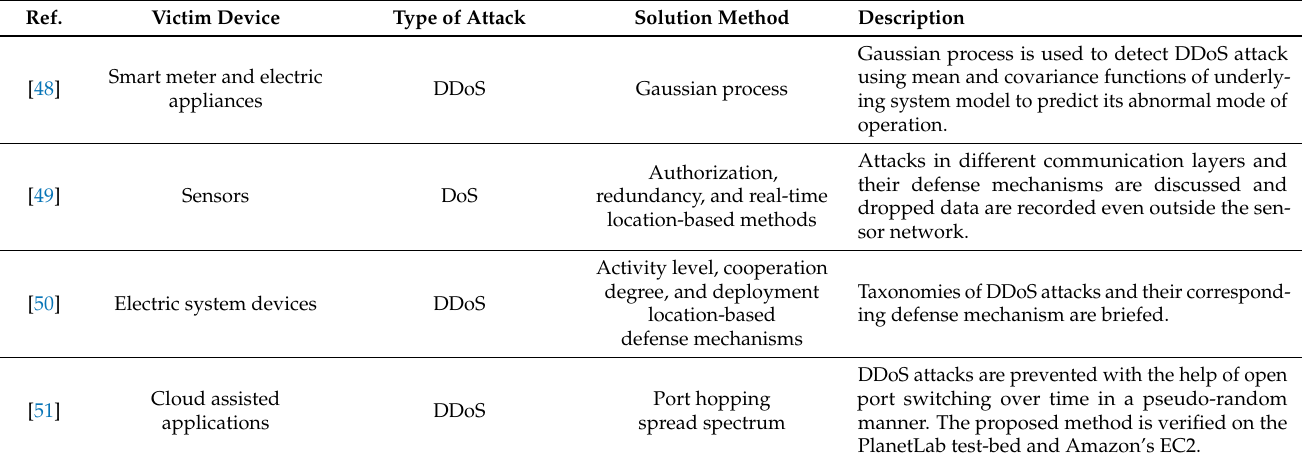
Table 3. Review of DoS and DDoS attacks detection in smart grid